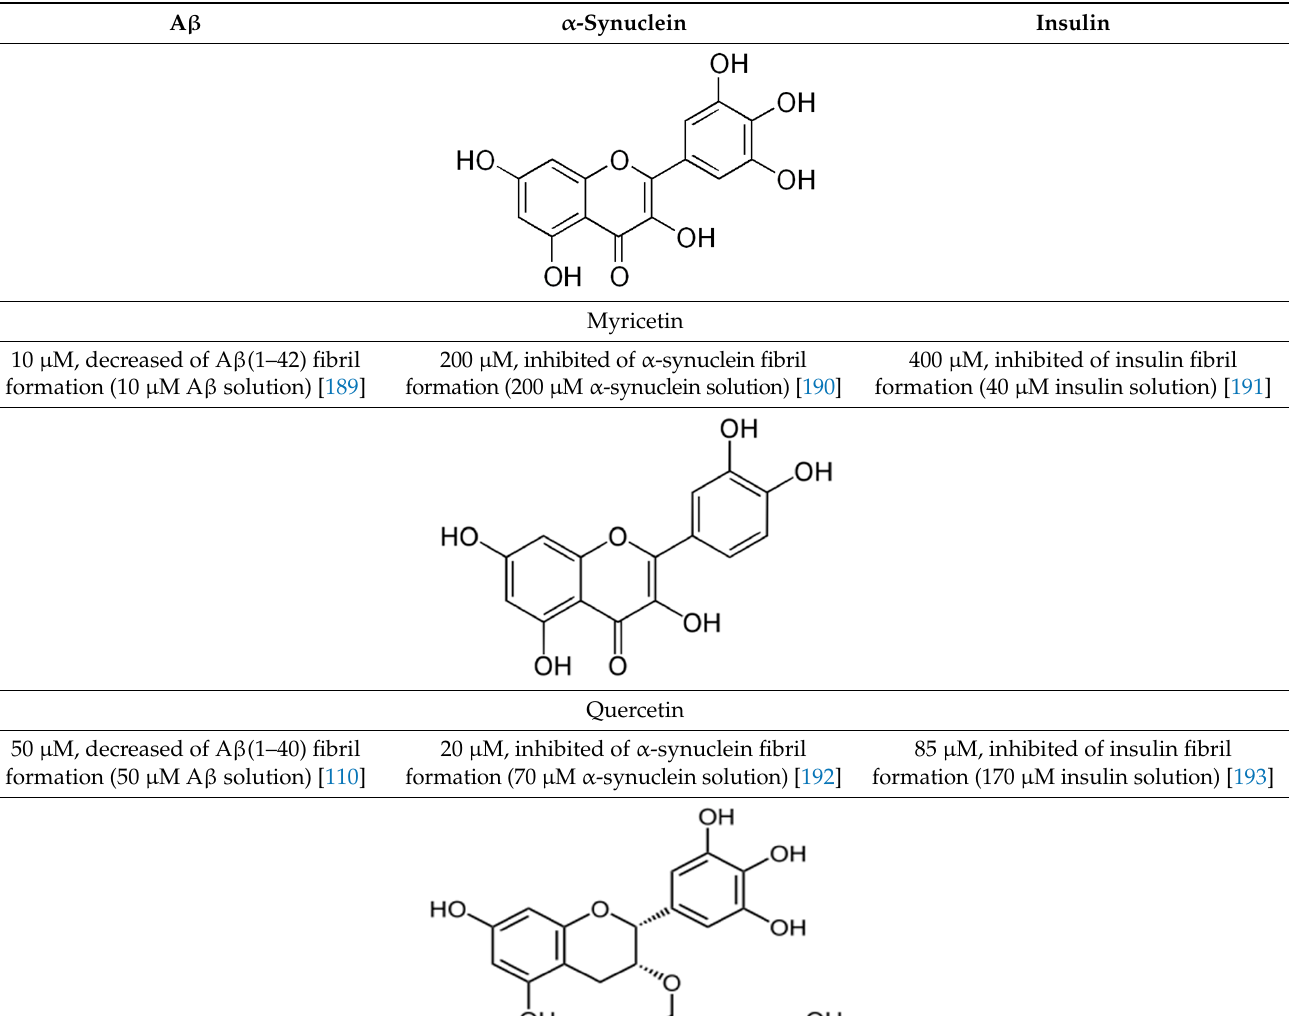
Table 1. Common inhibitors for A β , α -synuclein, and insulin.